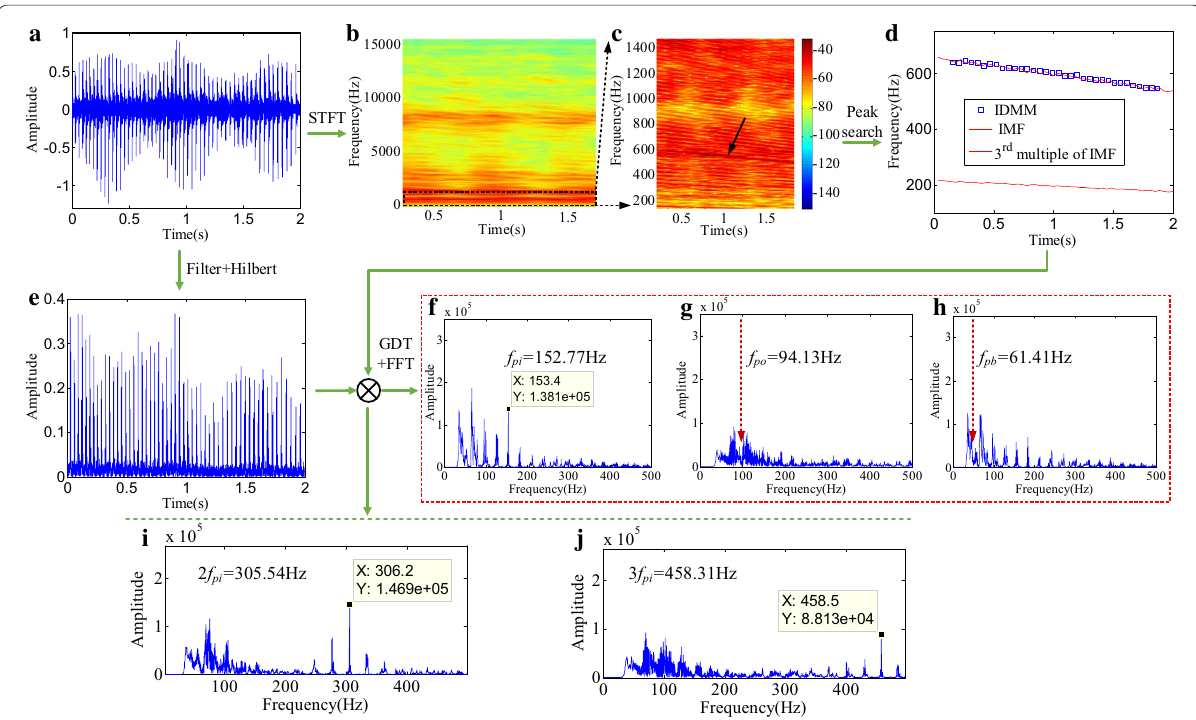
Figure 11 Analysis results of inner race fault signal: a raw signal, b TFR of raw signal, c partial enlargement of TFR, d extracted IDMM, e envelope of filtered signal; Spectra of demodulated signals with different PFs: f s i ( t ), g s o ( t ), h s b ( t ), i 2 s i ( t ), j 3 s i ( t )